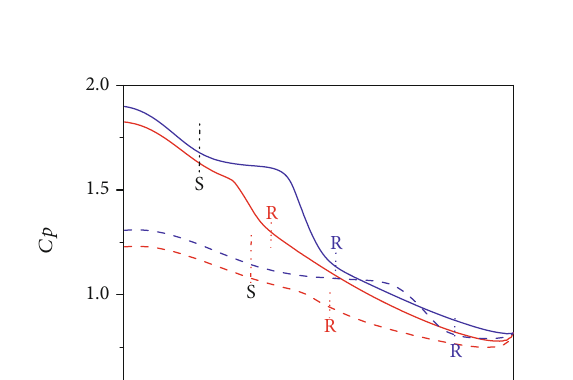
Figure 15: C p comparison with di